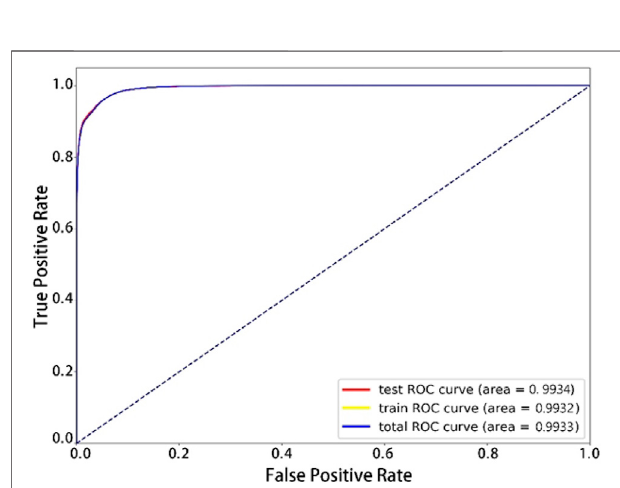
FIGURE10 | ROCcurve veri fi cation results (the veri fi cation results of the ROC curve include the test ROC curve, train ROC curve and total ROC curve, andthethreevaluestogetherdeterminetheaccuracyoftheresults.Thecloser the area under different curves is to 1, the higher the accuracy will be).